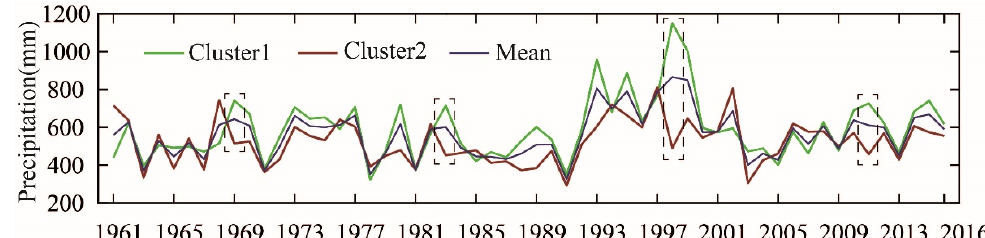
Figure 5. Changes in the annual precipitation in the whole basin and the two precipitation clusters over 1961–2016 in the Poyang Lake basin.